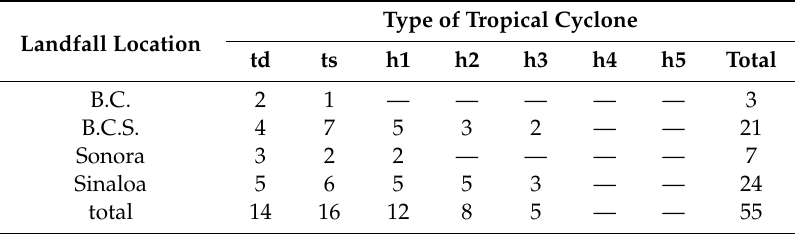
Table 4. Number of tropical depressions (td), tropical storms (ts) and hurricanes (h) category 1 to 5 making landfall in the GC during the period 1980–2019. Source: National Oceanic and Atmospheric Administration (2020).